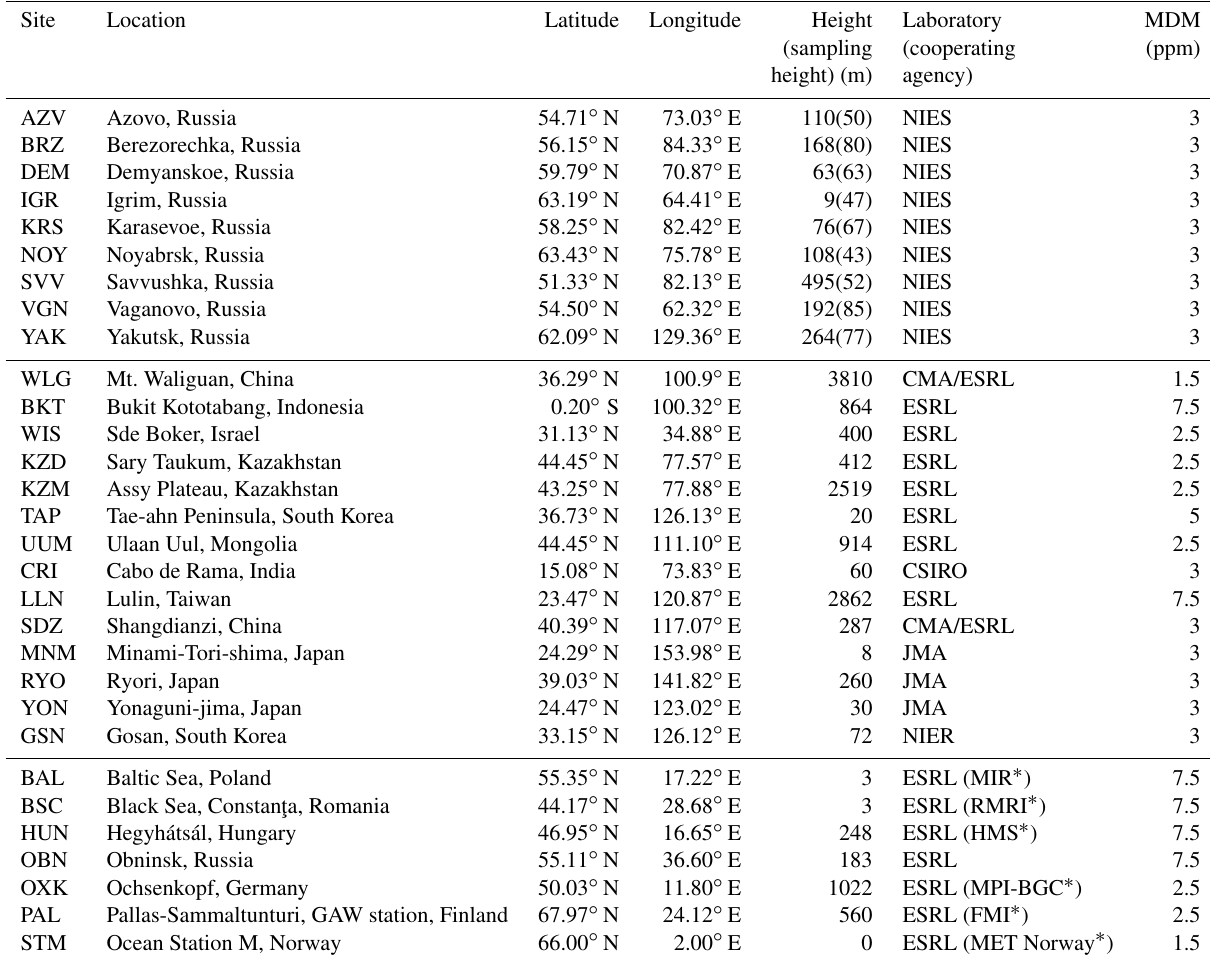
Table 1. Information on observation sites located in the Asia and Europe region. MDM represents the model–data mismatch, which is the observation